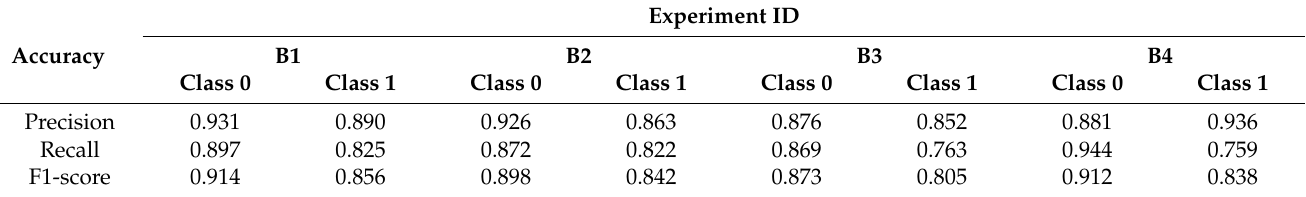
Table 2. Scores of the four best experiments related to the second scenario. Class 0 identifies non- consumed land; class 1 identifies consumed land.